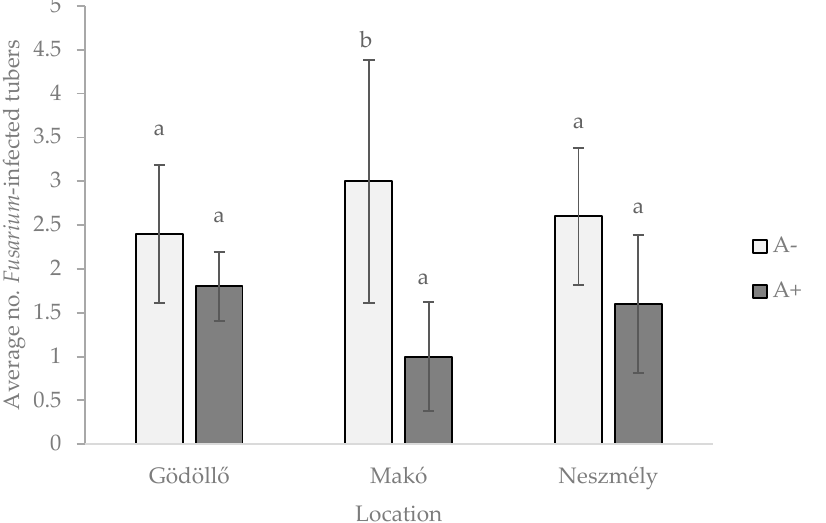
Figure 12. Effect of the presence of Armadillidium vulgare (A+) on the number of infected tubers in three locations (Gödöll ő , Makó, Neszmély) in 2018, as determined by the naked eye. Different letters above the bars indicate a significant ( p ≤ 0.05) difference between two treatments according to ANOVA and Tukey’s pairwise comparisons; error bar: CI 95%.